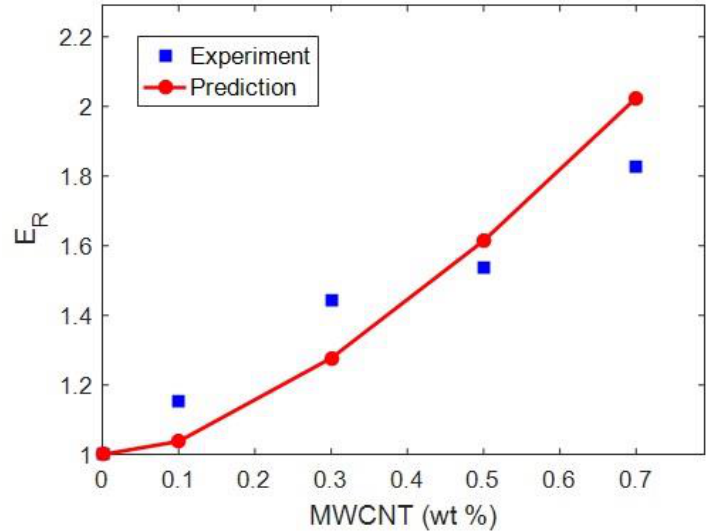
Figure 8. Experimental and theoretical relative modulus by the advanced Takayanagi model (2) for epoxy / MWCNT nanocomposites (Equation (2) for epoxy/MWCNT nanocomposites [56].